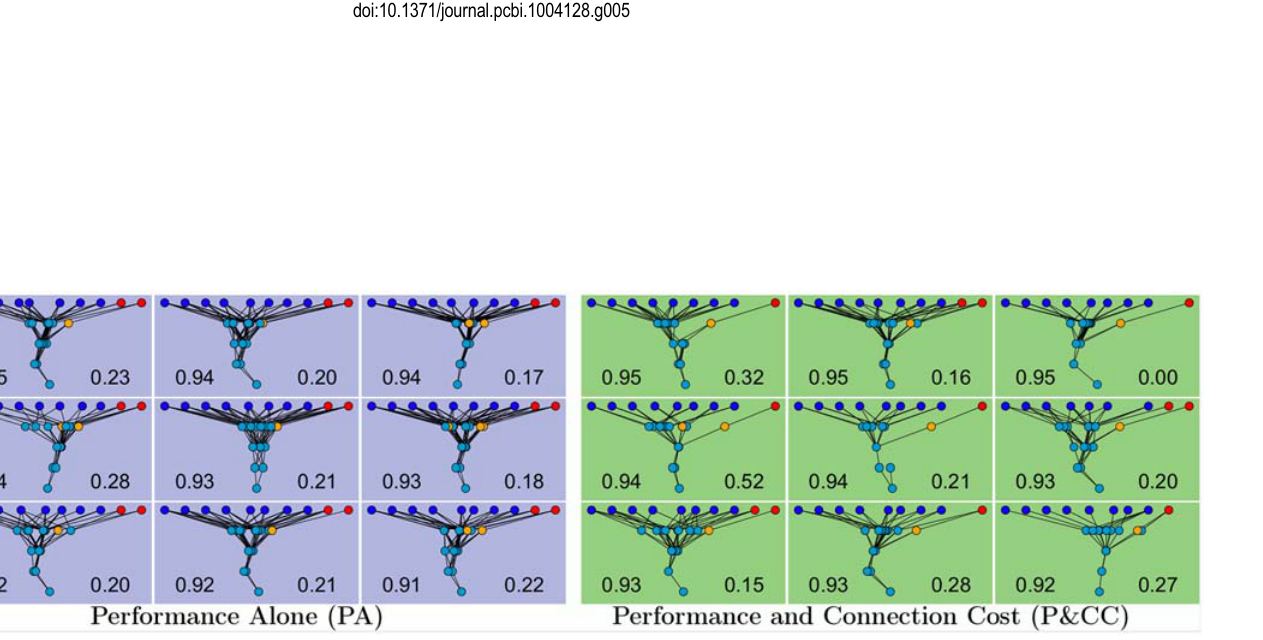
Fig 6. PA networks are visually non-modular whereas P&CC networks tend to create a separate module for learning (red and orange neurons), as hypothesized in Fig. 1 (bottom). Dark blue nodes are inputs that encode which type of food has been encountered. Light blue nodes indicate internal, non- modulatory neurons. Red nodes are reward or punishment inputs that indicate if a nutritious or poisonous item has been eaten. Orange neurons are neuromodulatory neurons that regulate learning. P&CC networks tend to separate the reward/punishment inputs and neuromodulatory neurons into a separate module that applies learning to downstream neurons that determine which actions to take. For each treatment, the highest-performing network from each of the nine highest-performing evolution experiments are shown (all are shown in the Supporting Information). In each panel, the left number reports performance and the right number reports modularity. We follow the convention from [23] of placing nodes in the way that minimizes the total connection length.